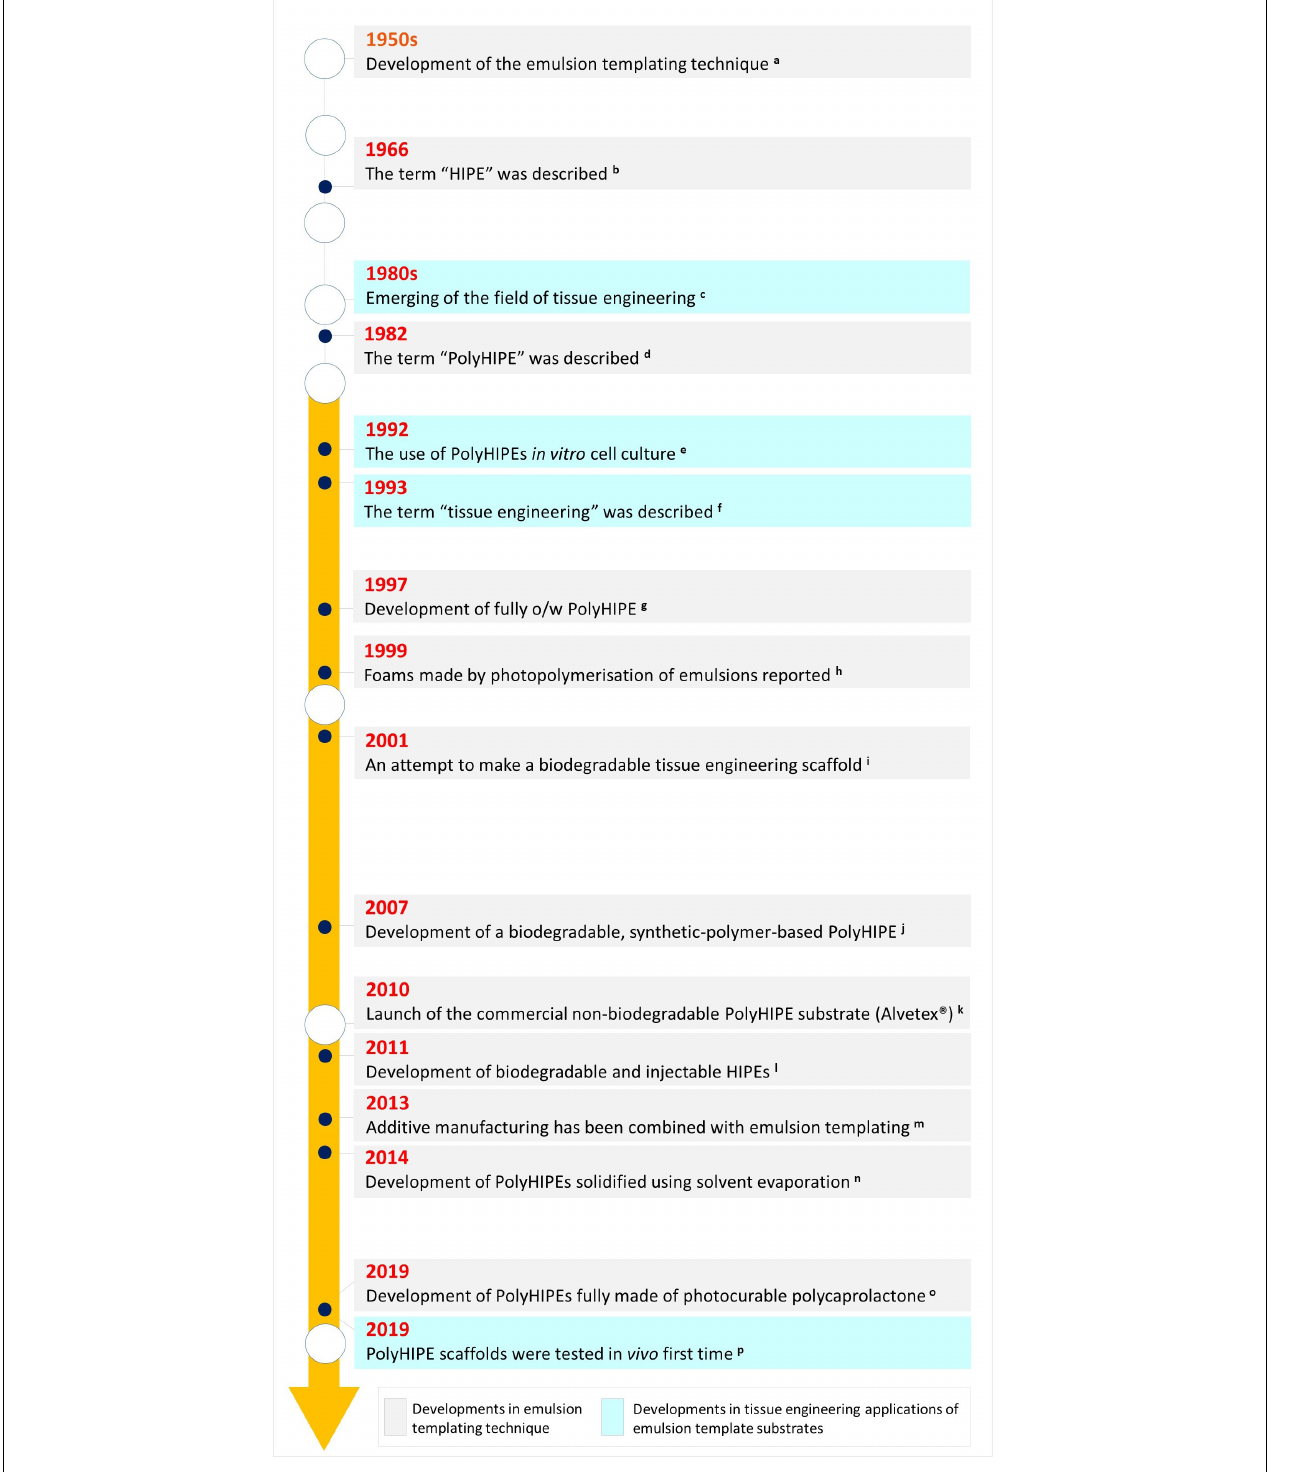
Frontiers in Bioengineering and Biotechnology |